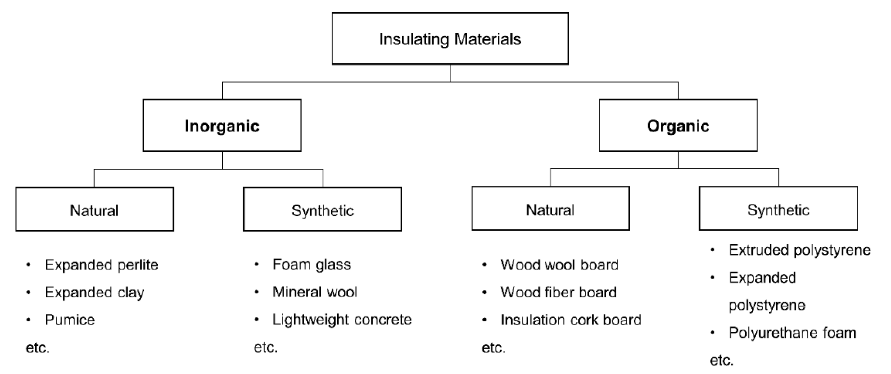
Figure 1. Classification of thermal insulation materials according to Reference [2].